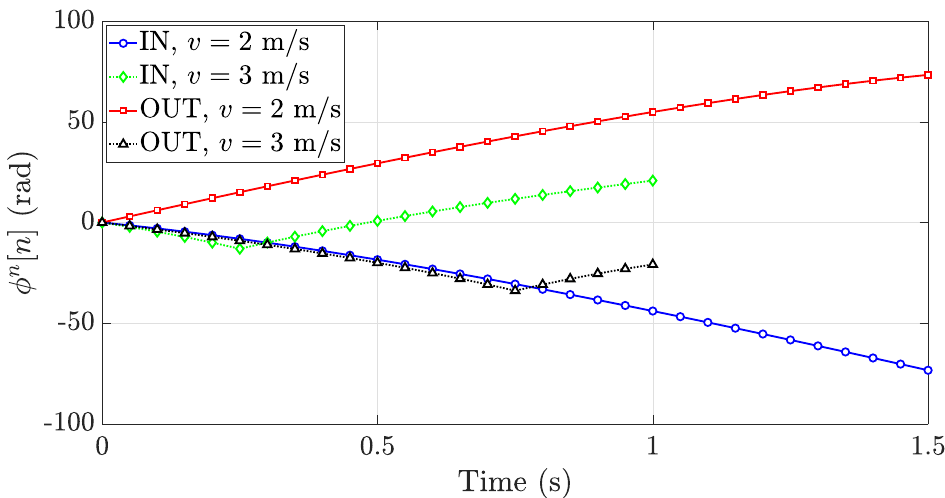
Figure 11. Time behavior of the normalized unwrapped phase in the asymmetrical antenna de- ployment for IN and OUT actions by varying the speed v when the parameters are the following: f = 865.7 MHz, l 1 = 1 m, l 2 = 4 m, ∆ h = 2.5 m, and T = 50